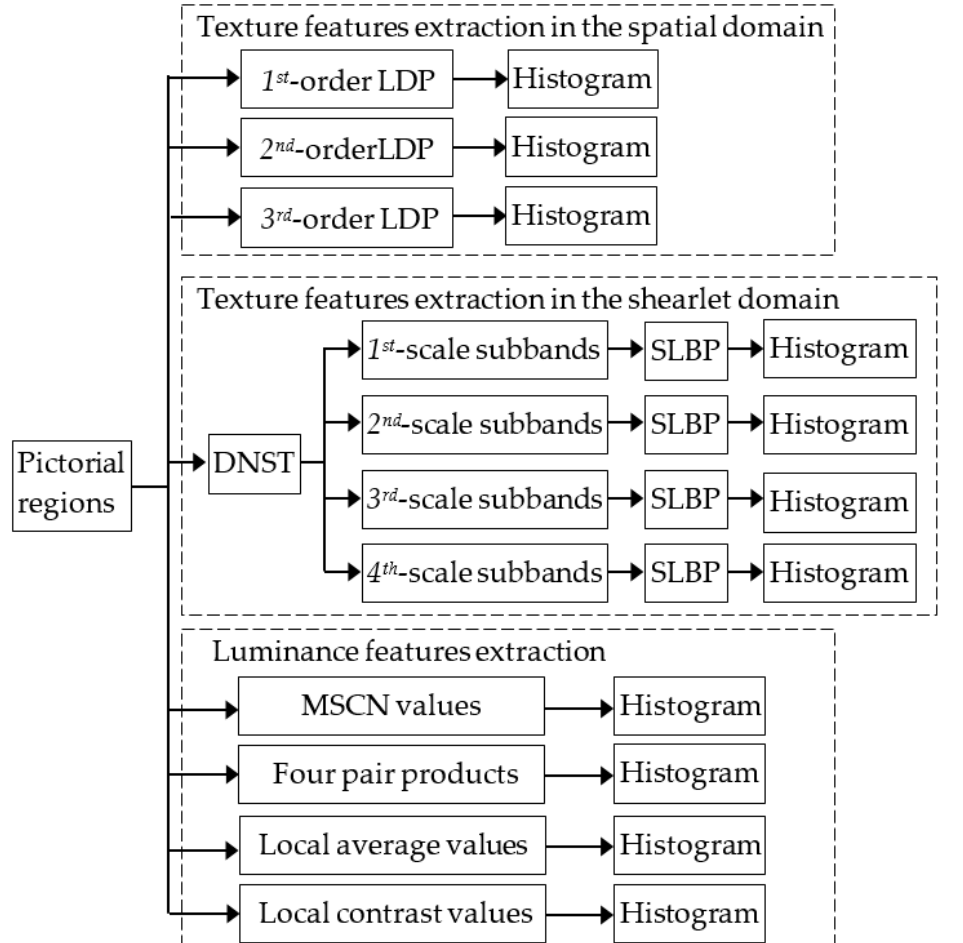
Figure 6. The process of the feature extraction of pictorial regions.